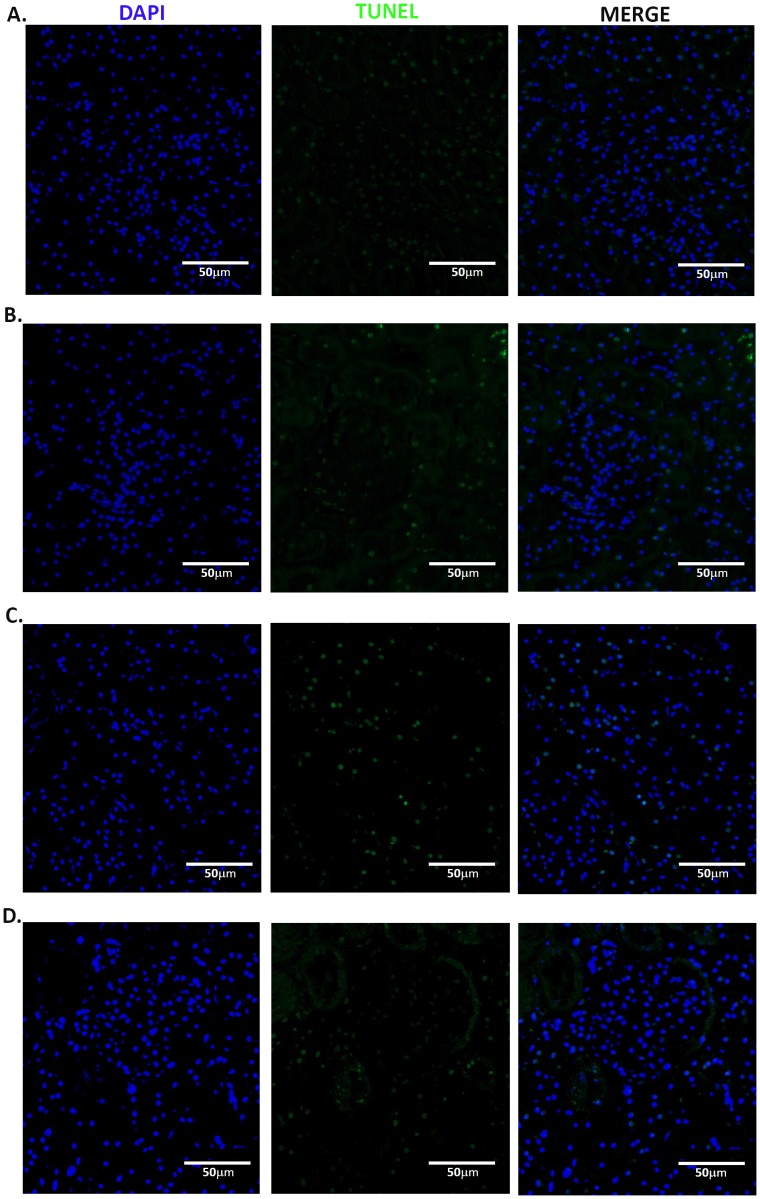
Glomerular TUNEL assay consisting of DAPI (nuclei), fluorescein (apoptotic marker), and merged sections for each group (vehicle+vehicle (A); vehicle+celecoxib (B); misoprostol+misoprostol (C); misoprostol+celecoxib (D)). 20x magnification.